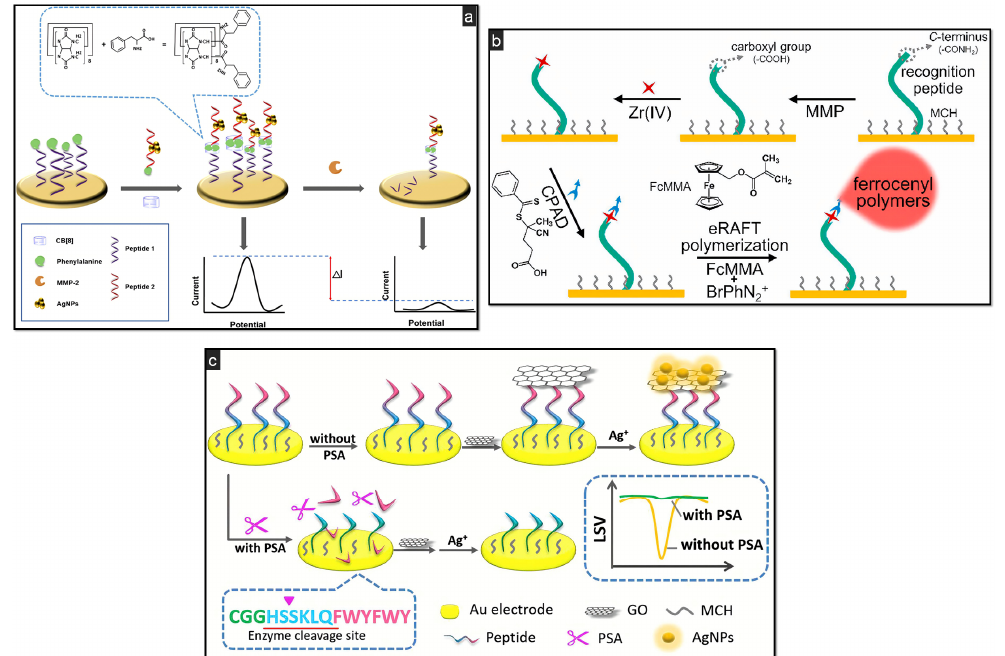
Figure 2. Schematic illustrations of different protease-based catalytic biosensors: ( a ) signal-amplified detection of MMP-2 through anodic stripping of AgNPs, using CB [8] as macrocyclic receptor to bind two aromatic amino acid residues via host–guest interactions, reprinted with permission from [76]; ( b ) signal-on MMP’s activity detection using a carboxyl group- free recognition peptide as proteolytic substrate, immobilised via Au–S self-assembly. Grafting of Fc polymers through eRAFT polymerization of ferrocenylmethyl methacrylate (FcMMA), reprinted with permission from [65]; ( c ) GO/AgNPs nanocomposite for the determination of PSA on Au electrode by means of linear sweep voltammetry (LSV), reprinted with permission from